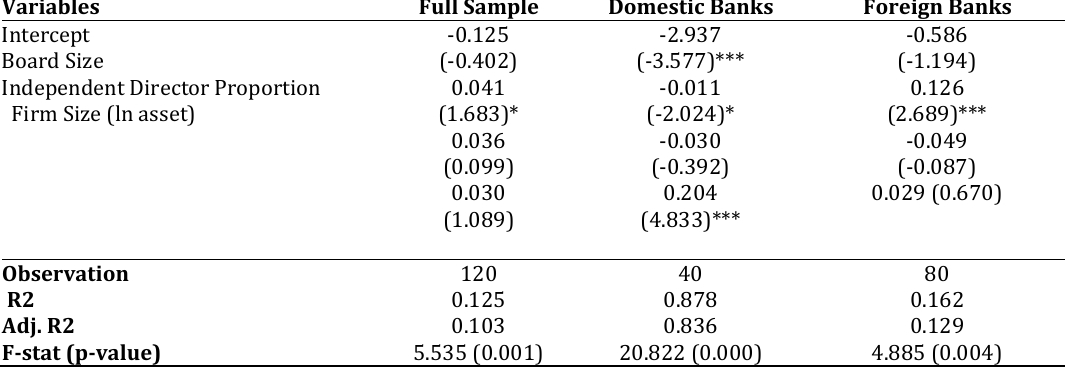
Table 9: The Regression Models for Loan to Deposit Ratio (LDR)